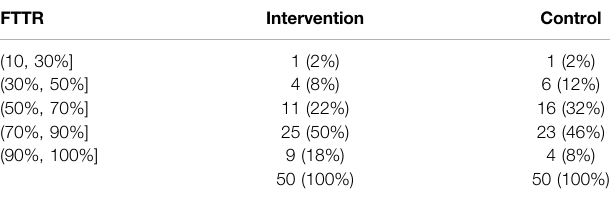
TABLE 4 | Patients ’ distribution in the FTTR. FTTR